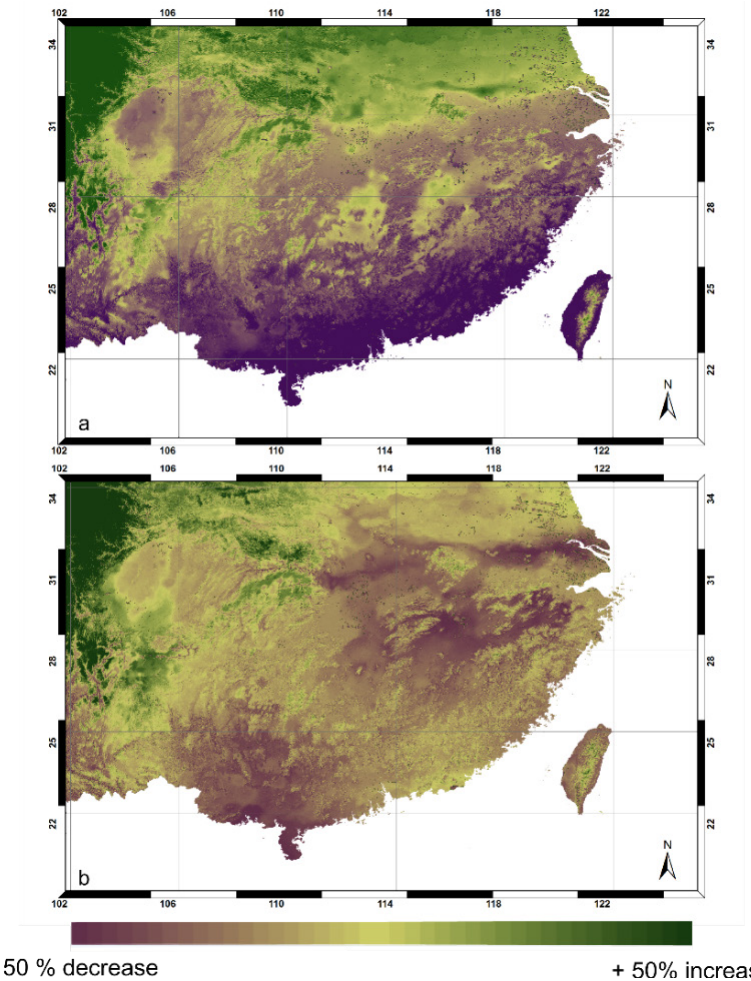
Figure 10. Percent changes in NPP between baseline and climate projection; ( a ) A1B projection; ( b ) A2